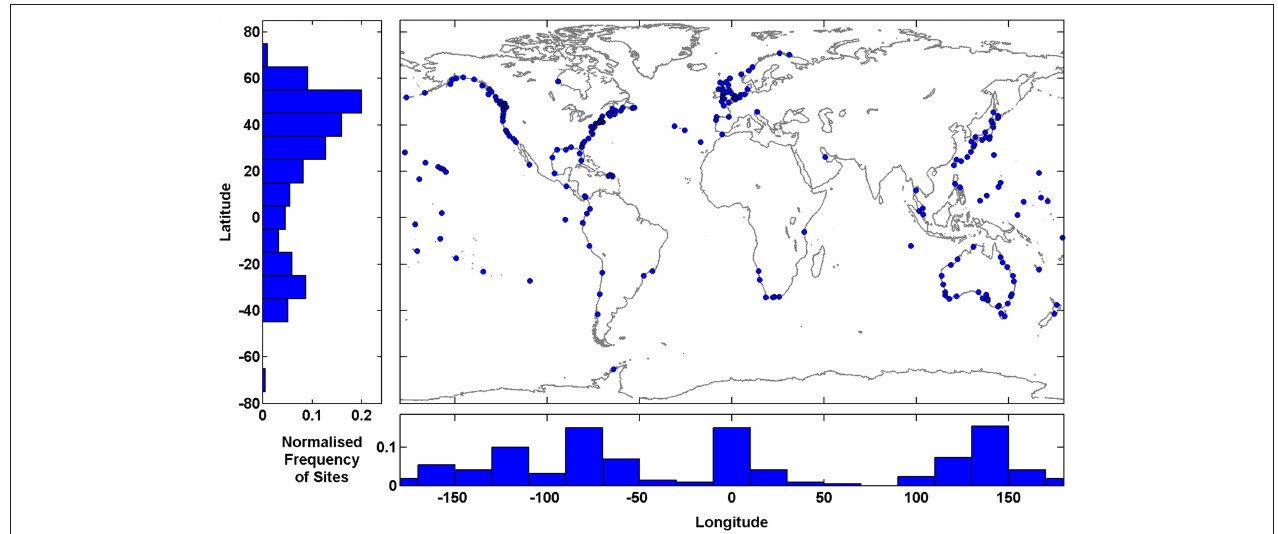
FIGURE 1 | Location map of 220 selected sites used in the analysis. Normalized frequency histograms are plotted along the x-axis for longitude and y-axis for